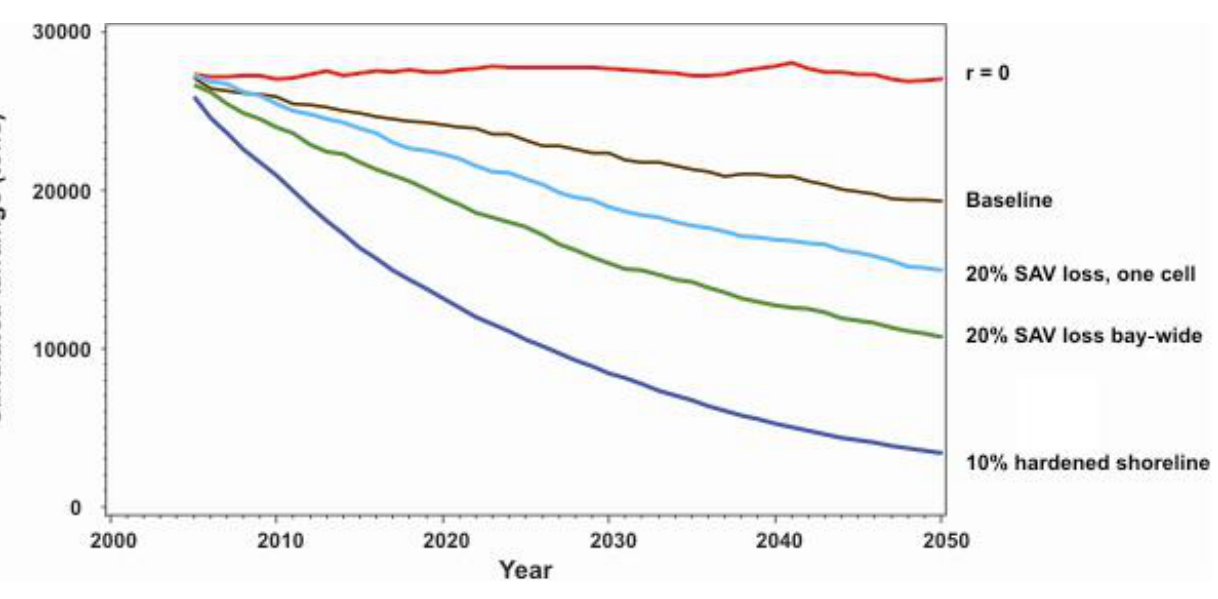
Fig. 8. Simulated blue crab landings based on five scenarios. SAV = shoreline aquatic vegetation. See Methods: Mobile Bay recruitment analysis for an explanation of the